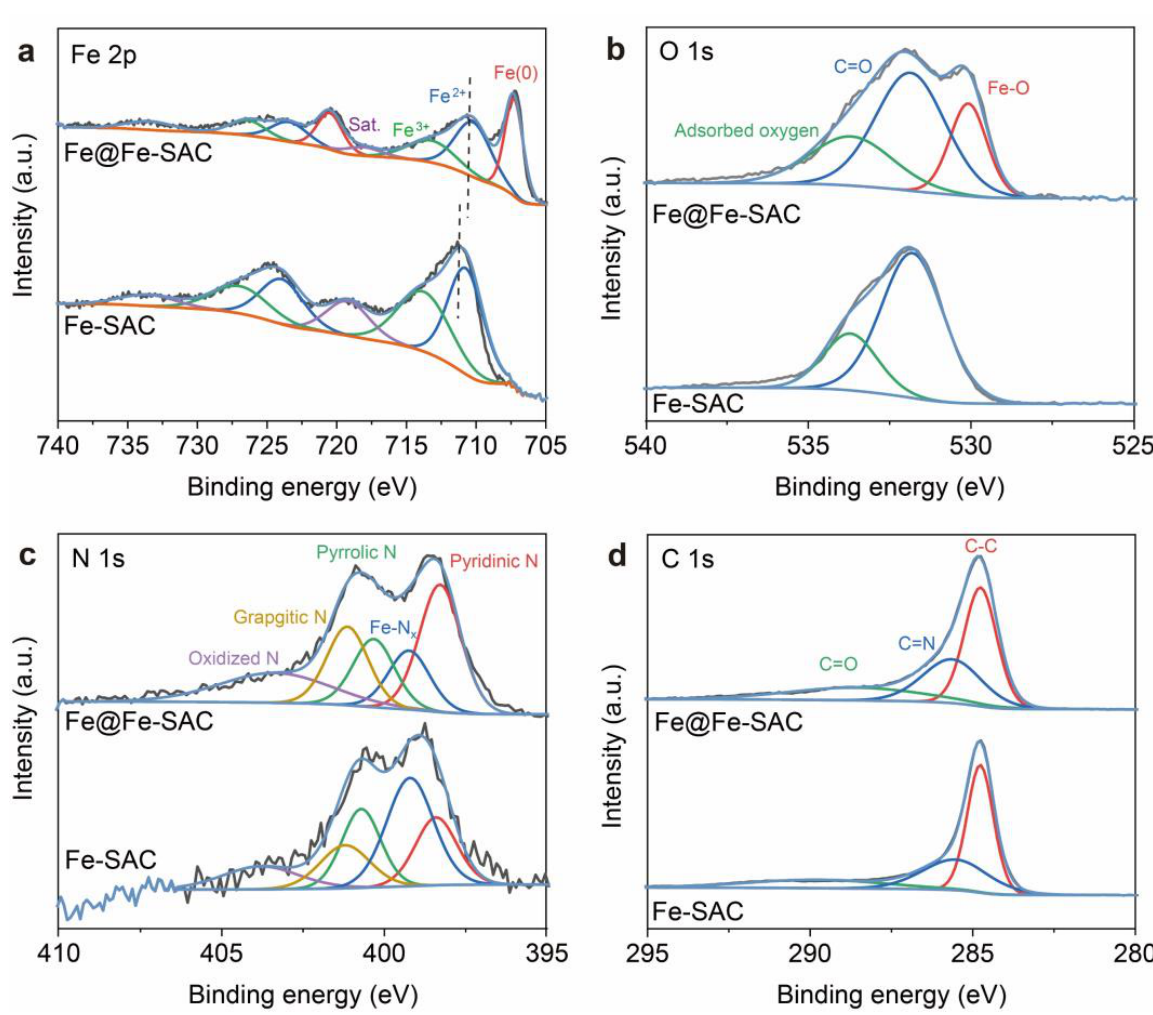
Figure 3. XPS spectra of Fe@Fe-SAC and Fe-SAC. ( a ) Fe 2p XPS spectra, ( b ) O 1s XPS spectra, ( c ) N 1s XPS spectra, and ( d ) C 1s XPS spectra.